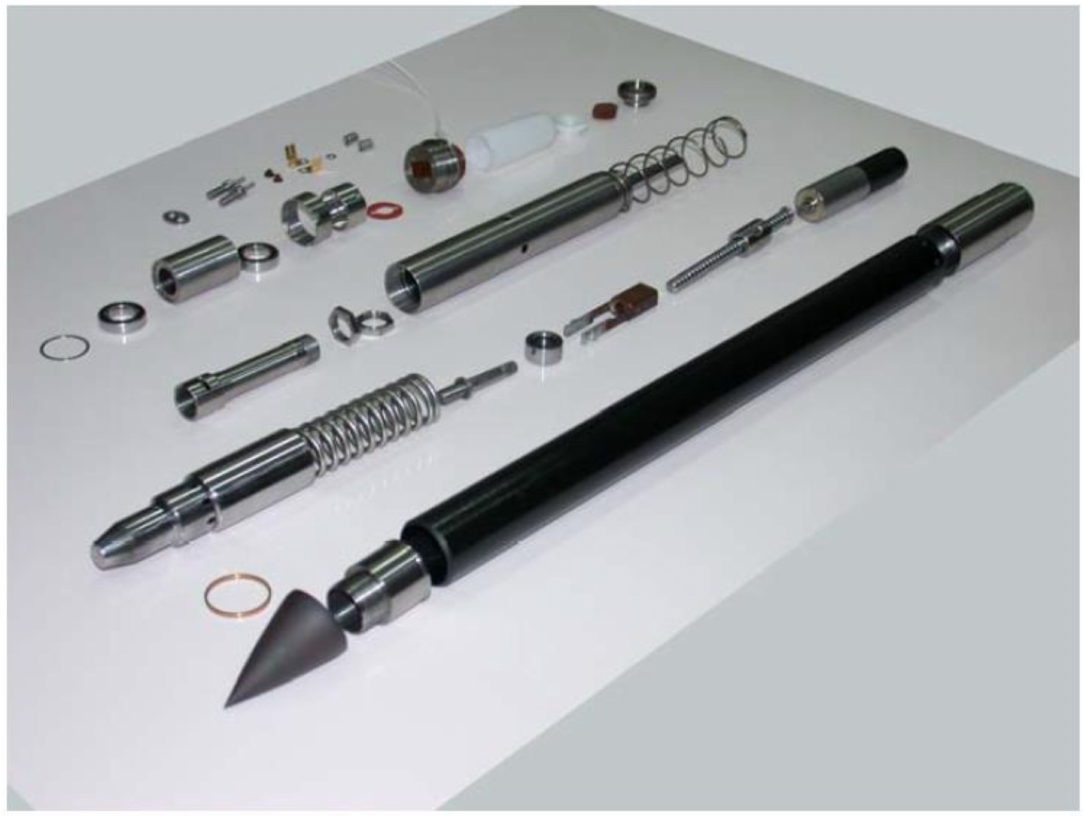
Figure 6. Basic components from which the KRET penetrator was